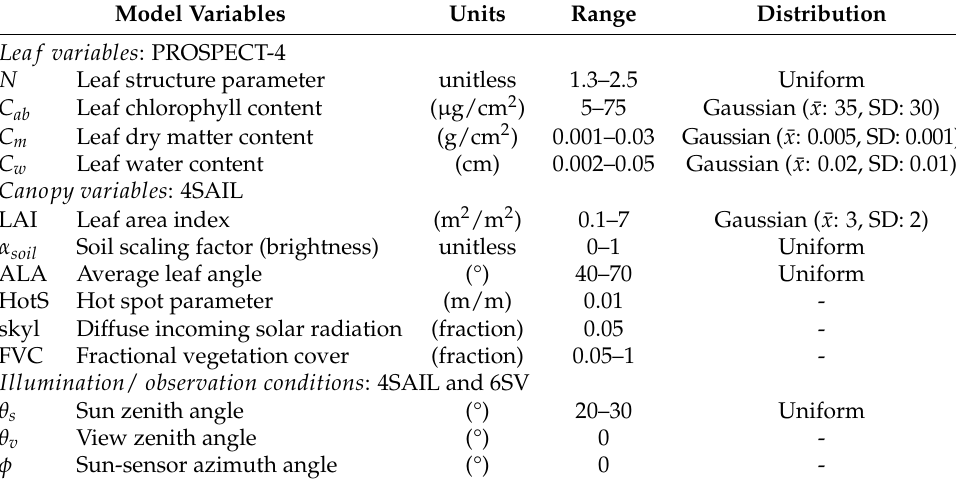
Table A1. Parameterization of leaf (PROSPECT-4) and canopy (4SAIL) parameters, with the notations, units, ranges, and distributions of inputs used to establish BOA synthetic reflectance